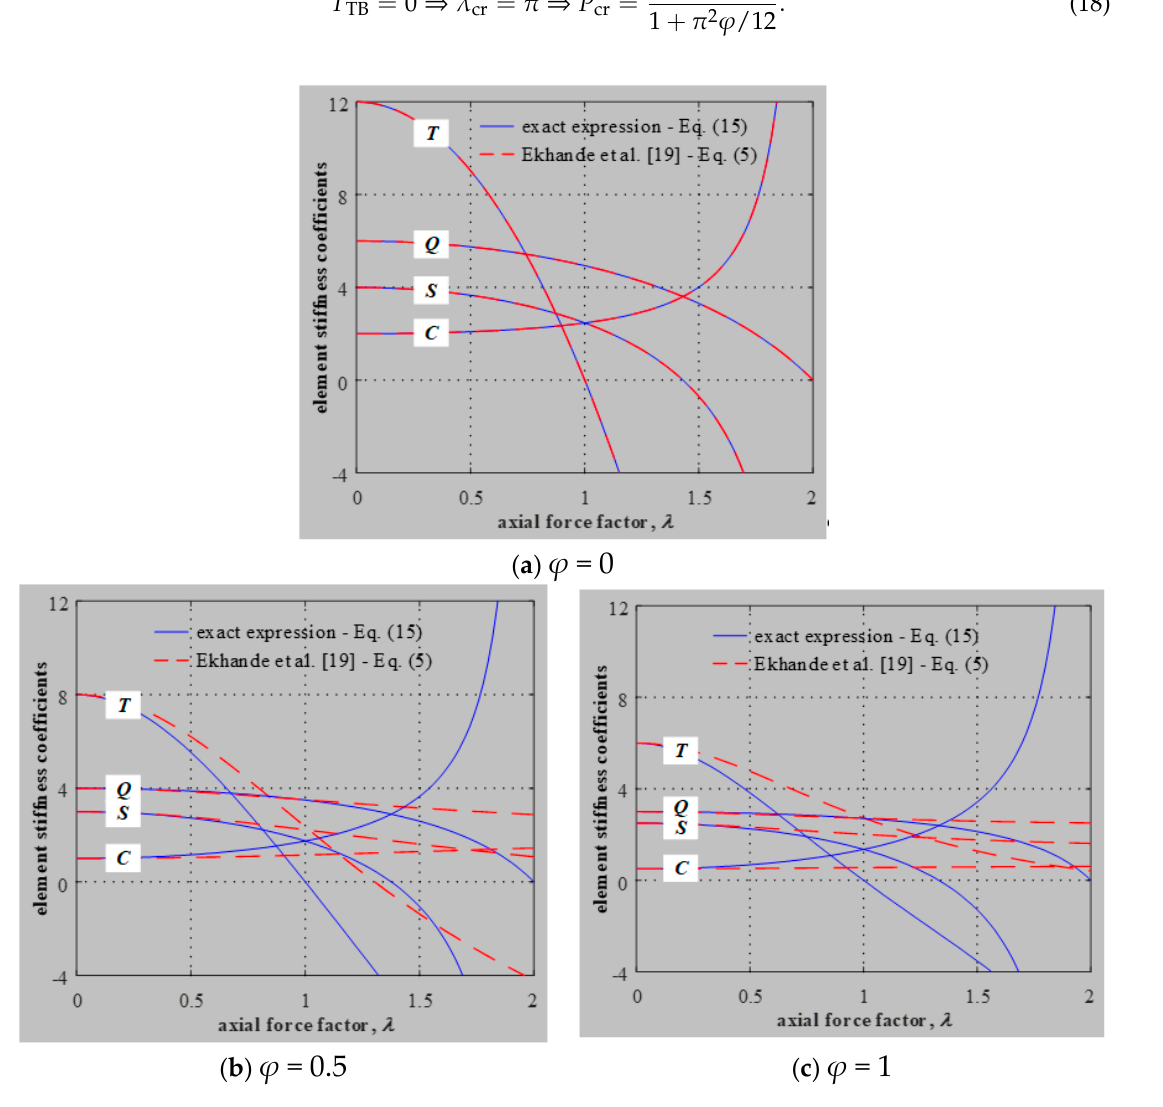
Figure 3. Influence of axial force factor on element stability functions by Equation (15) (exact expression) and Equation (5) (simplified expression by Ekhande et al. [18]).